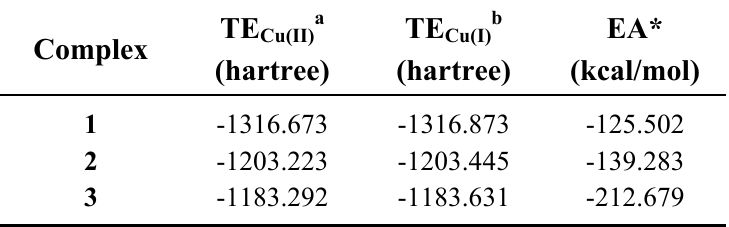
Table 5. Theoretical parameters of the copper